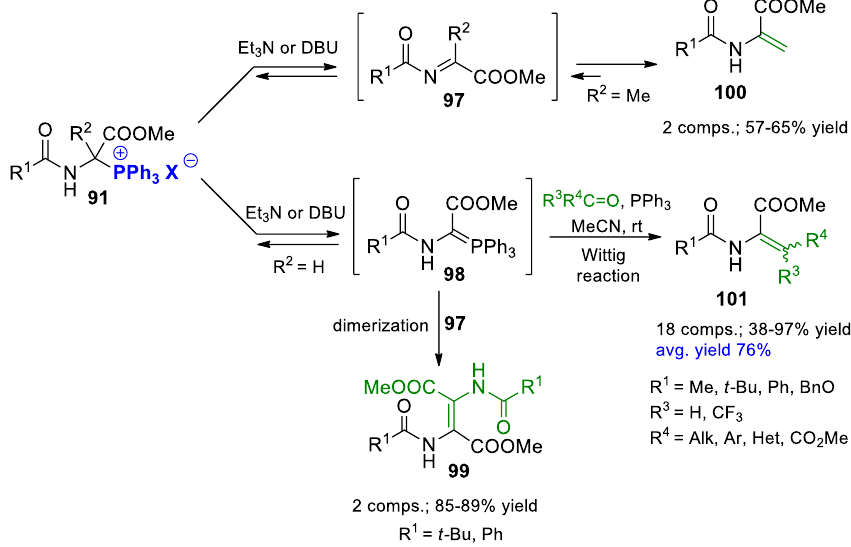
Molecules 2022 , 27 , 1562 25 of 34 Figure 7. Applications of N -acyl-1-phosphonio- α -amino acid esters 91 . The directions of N -acyl-  -triphenylphosphonio- α -amino acid esters reactivity, and thus, the possibility of their further applications, were recognized during comprehensive research on their behavior in the presence of organic bases [83]. Reactions of N -acyl-  - triphenylphosphonio- α -amino acid methyl esters 91 with DBU and triethylamine were investigated then as the crucial step of the base catalysed displacement of the tri- phenylphosphonium group by various nucleophiles. Initially, this was observed by Ko- ber, and Steglich, and later confirmed by Mazurkiewicz and Grymel, that N -acyl-  -tri- phenylphosphonioglycinates 91 , upon treatment with bases, were converted into a mix- ture of the corresponding N -acyliminoacetate 97 and N -acyl- 